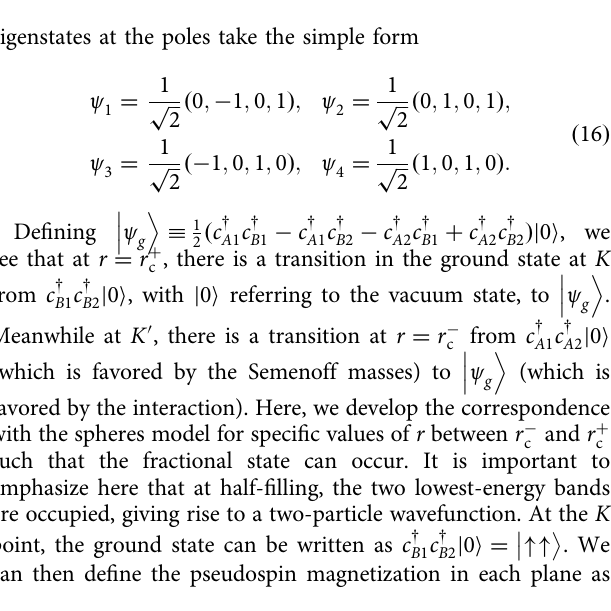
Fig. 2 Two stacked Haldane layers. a Bulk band structure through the high symmetry points. b Sublattice magnetization σ j z (cid:1) h n j k B (cid:3) n j k A i in one layer over the primitive cell of the reciprocal lattice at the K Dirac point, the light yellow color refers to magnetization 1, the K 0 Dirac point has a magnetization equal to 0 as a result of entanglement. c Entanglement entropy S 1 of one layer in the same region (yellow refers to a maximum entropy of ln4 and in the blue region the entropy is 0). The parameters ffiffiffi p ffiffiffi p t t = 3 (which is in the range chosen for all panels are j d z j ¼ 3 , r ¼ 3 ffiffiffi p 1 1 r (cid:3) r < r þ t = 4 (symmetric Semenoff masses). ), and M 1 ¼ M 2 ¼ 3 3 1 c < c Here, t 1 is the nearest-neighbor hopping amplitude, ∣ d z ∣ is the next-nearest- neighbor amplitude at the Dirac points, and M 1 , M 2 are the Semenoff masses in the two